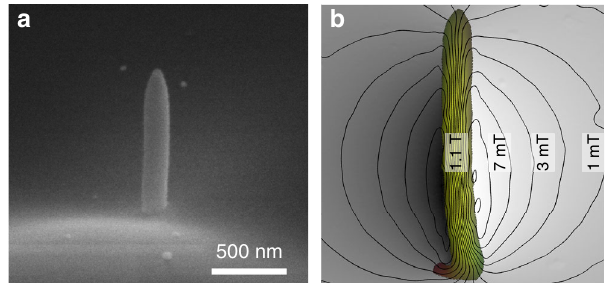
Fig. 1 Schematic illustration of the effect of the Lorentz force on an electron beam. The induced Lorentz forces due to in-plane uniform magnetic fi elds B x and B y , a and b , that are given by F y = − | e | v z B x and F x = − | e | v z B y deviate the incoming electron beam in the x and y directions, respectively. When the magnetic fi eld is parallel to the beam propagation direction, c , the Lorentz force vanishes, and thus the electron beam propagates without being affected by the out-of-plane magnetic fi eld. Small effects such as lensing and spin interactions on the electron beam wavefunction are neglected